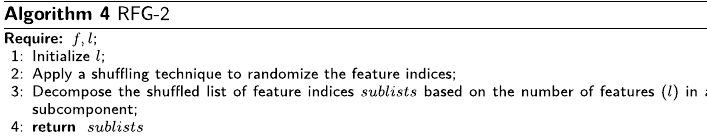
Algorithm 4 is the pseudocode of the proposed random feature grouping technique